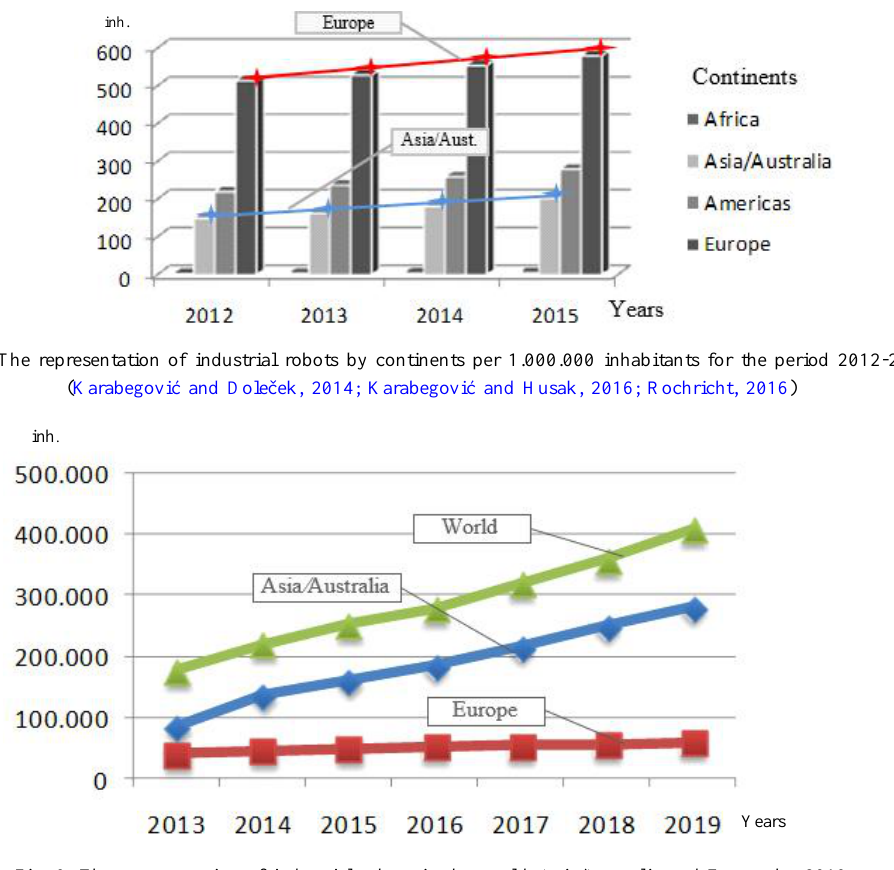
Fig. 9: The representation of industrial robots in the world, Asia/Australia and Europe by